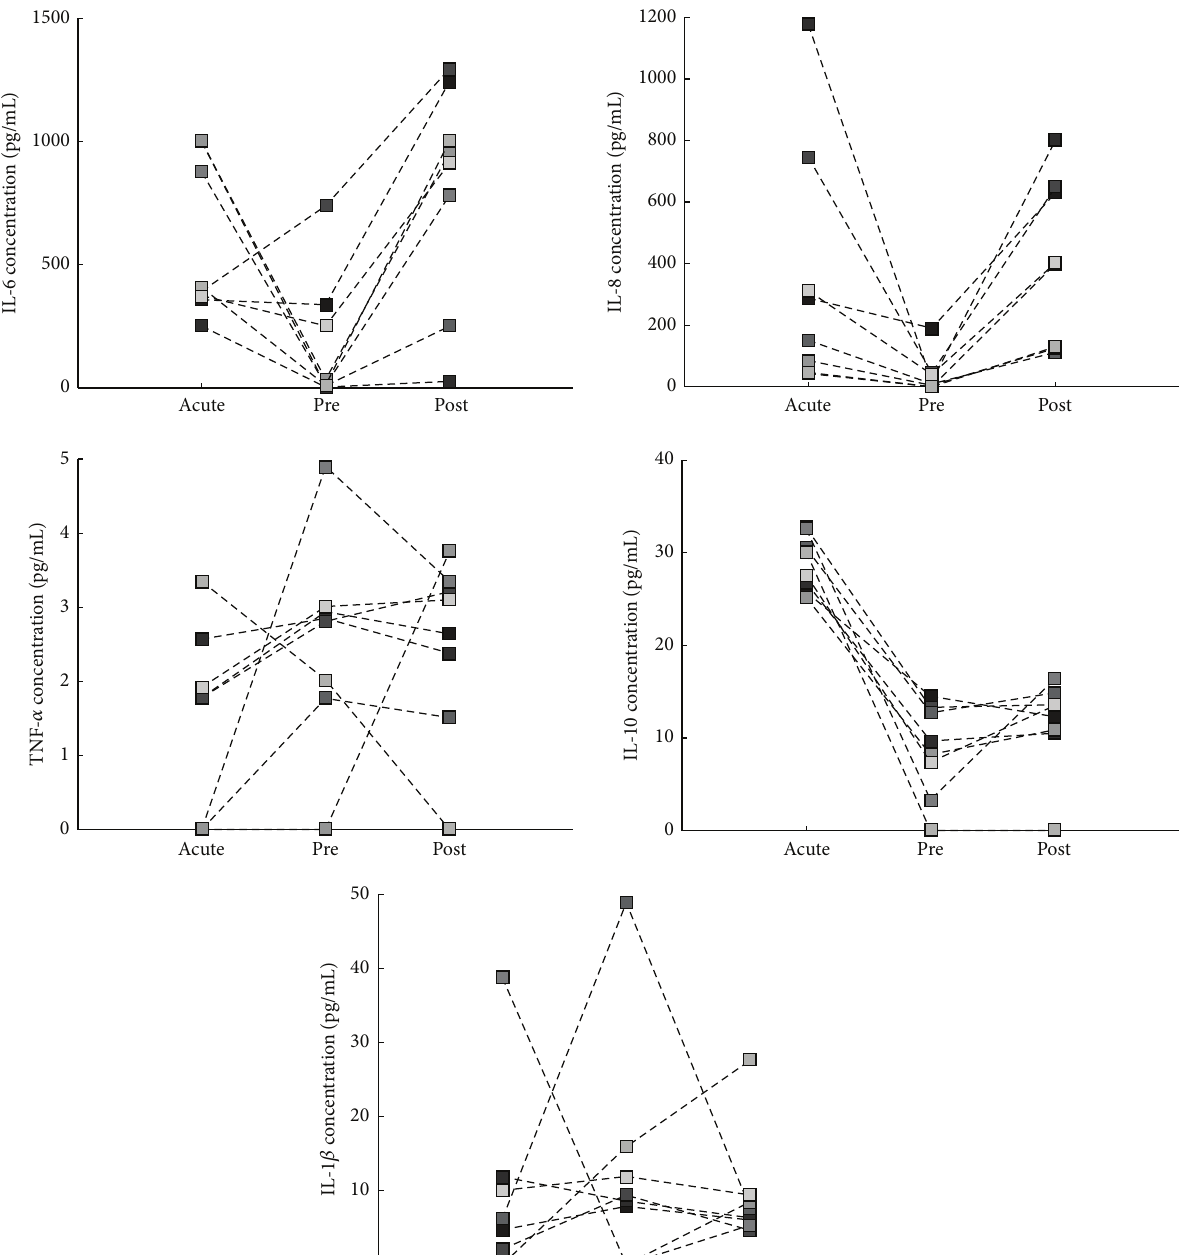
Figure 1: Cytokine levels in the synovial fluid of individual patients after ACL rupture. Squares represent values measured in single subjects ( 𝑛 = 8 ); each subject is represented with different grey values. Acute (less than 72 hours after ACL injury); pre (1 month after the trauma, in or before the arthroscopic ACL reconstruction surgery); post (1 month after the